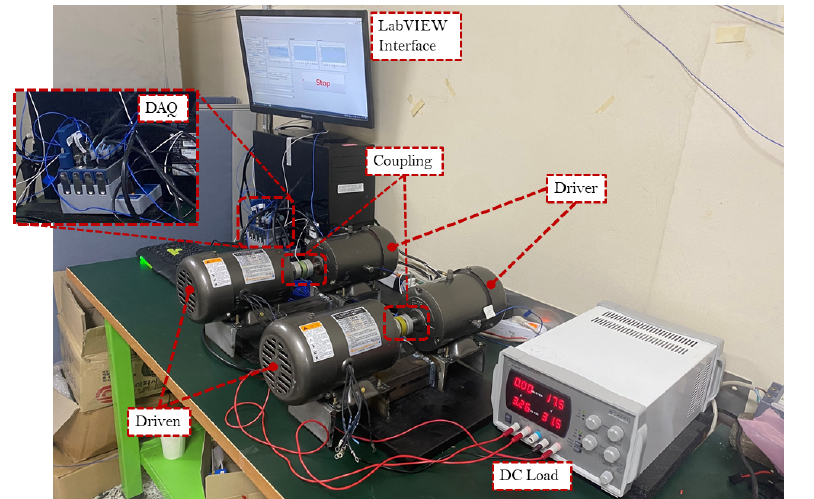
Figure 5. A pictorial illustration of the experimental